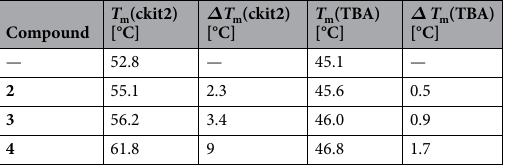
Table 3. Thermal stability of ckit2 and TBA with compounds 2 – 4 measured by CD melting experiment.